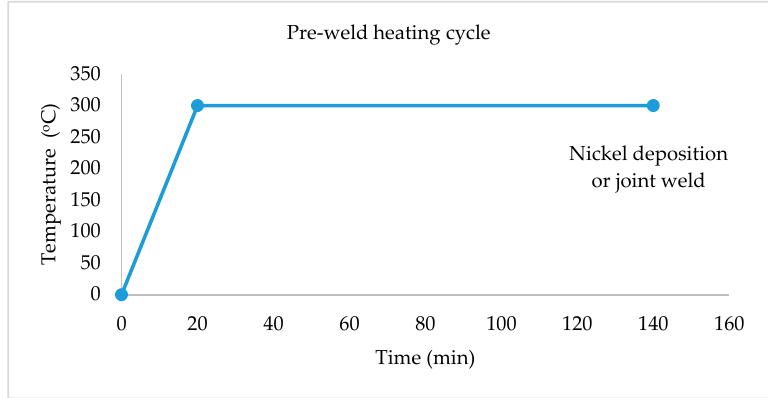
Figure 2. Test specimen pre-heating cycle for Nickel deposition or joint weld.